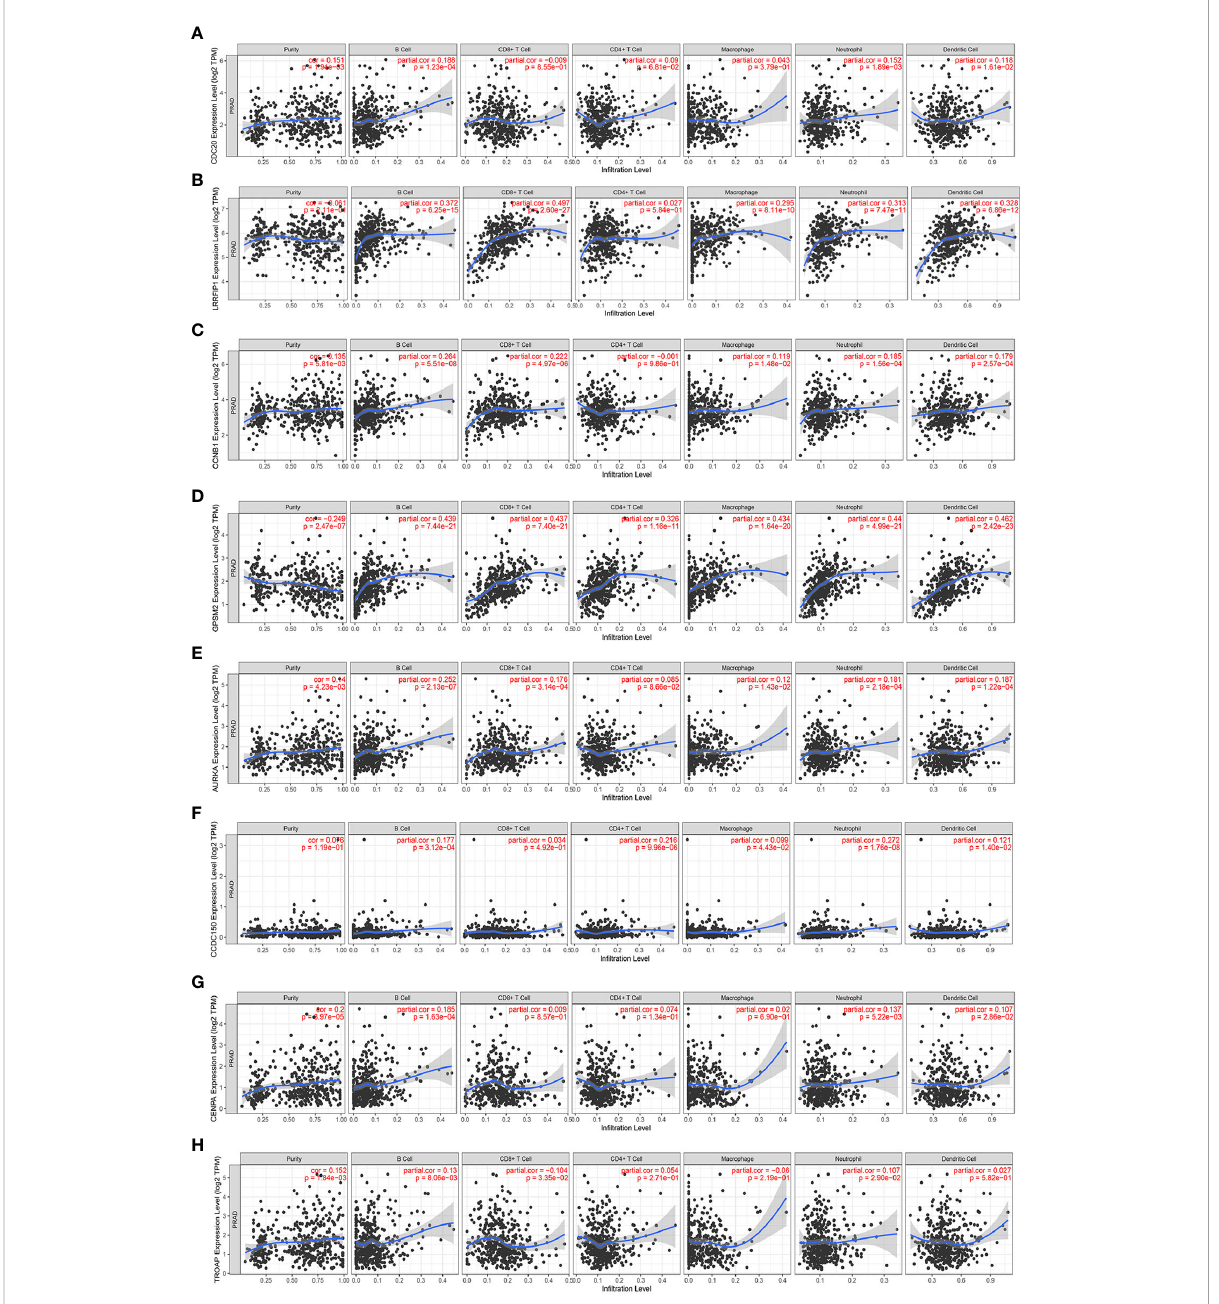
FIGURE 7 The correlation between the expression of vinblastine resistance-related genes and immune cell in fi ltration from TIMER webtool. (A) CDC20 (B) LRRFIP1 (C) CCNB1 (D) GPSM2 (E) AURKA (F) CCDC150 (G) CENPA (H) TROAP